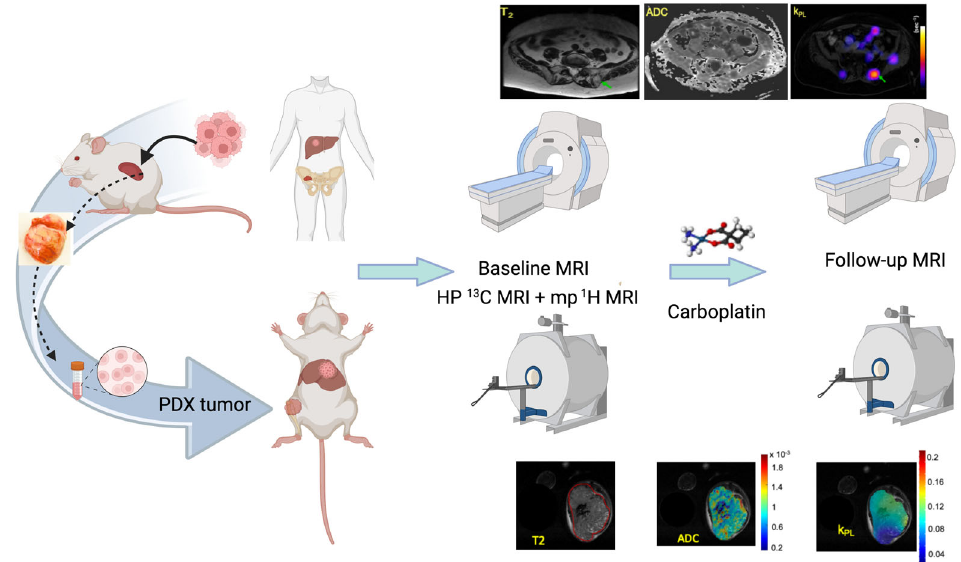
Figure 1. The UCSF co-clinical project schema. The project focuses on assessing the response of SCNC to standard-of-care platinum-based chemotherapy using HP [1- 13 C]pyruvate MRI. The co-clinical project uses three established SCNC PDX that are propagated in the murine kidney, digested into single cells, and inoculated in the murine tibia and liver to match the metastatic SCNC patient population under study in the clinical trial. Upon reaching a volume of ~0.3 cc, assessed by MRI, tumors are characterized by baseline dynamic HP [1- 13 C]pyruvate MRI and mp- MRI. Following one cycle of treatment with carboplatin or placebo, tumors are again evaluated by combined dynamic HP [1- 13 C]pyruvate MRI and mp-MRI to investigate the reduction in the HP 13 C MRI metric (apparent rate of conversion of [1- 13 C]pyruvate to [1- 13 C]lactate, k PL ) as an early marker of response to chemotherapy. As a part of both clinical and pre-clinical protocols, k PL maps are overlaid on the corresponding T 2 weighted anatomic images and correlated with changes in ADC images and tumor growth rate with